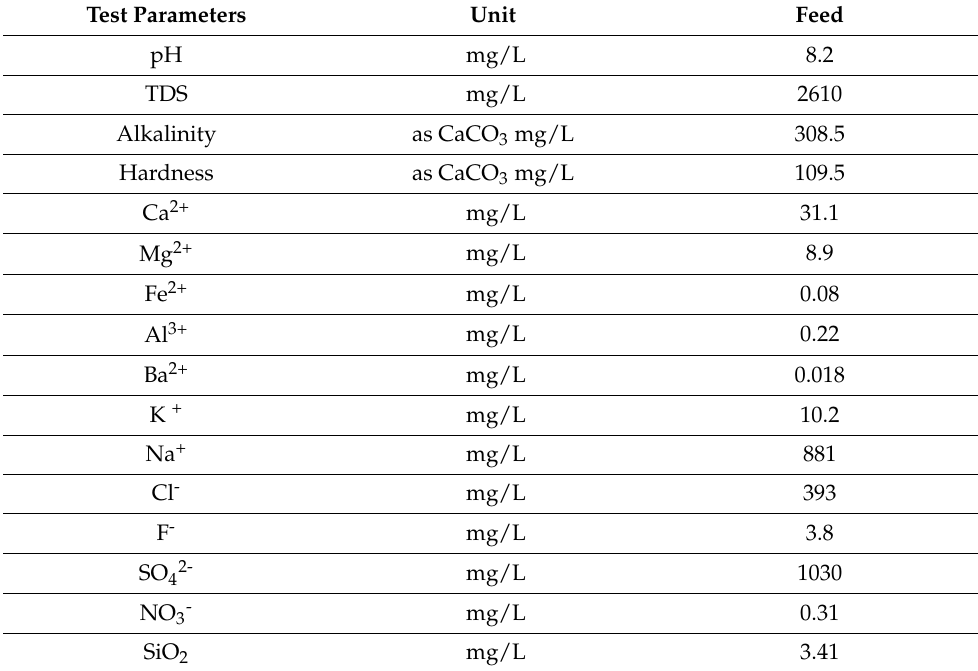
Table 1. Inorganic salt compositions of feedwater to BWRO unit in the Hongqinghe coal mine water treatment plant.